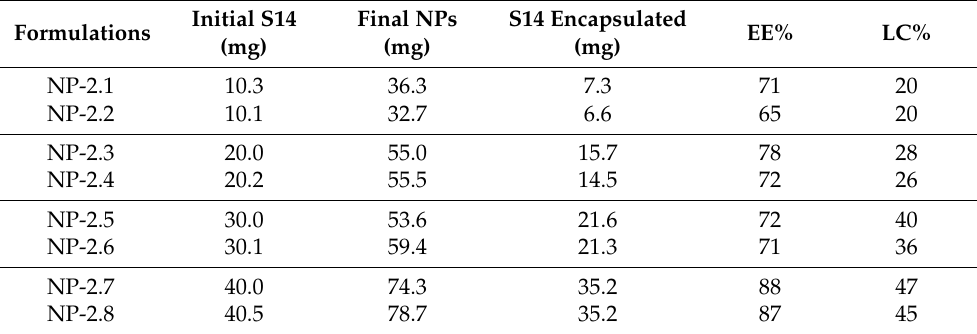
Table 3. Encapsulation efficiency and drug-loading capacity of S14-loaded PLGA nanoparticles prepared by duplicate using nanoprecipitation methodology.